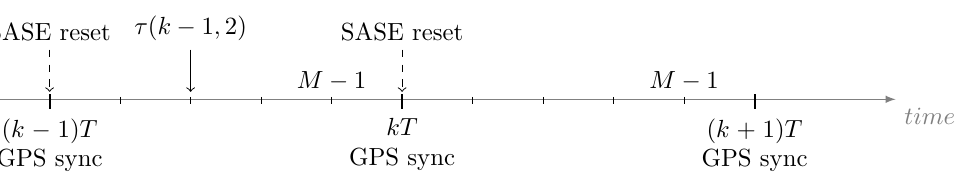
Figure 2. Discrete time-line representation in a universal time frame, where it is illustrated how using Algorithm 1, the filter reinitialize the initial condition every T[s]